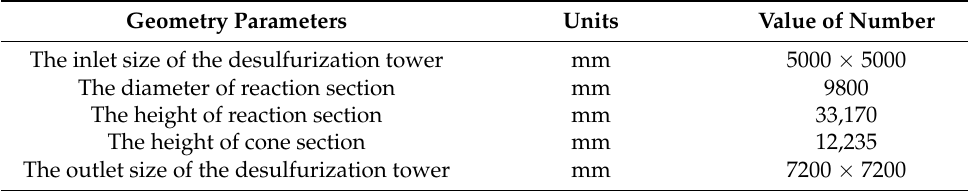
Table 1. The geometry parameters of the desulfurization tower.